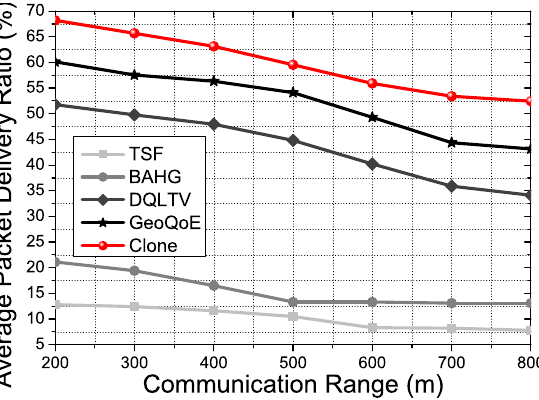
Figure 12. APDR for communication range and average density rate.